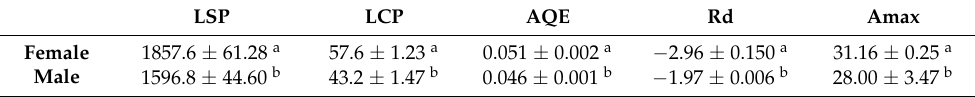
Table 3. Characteristic parameters of Pn-PAR in male and female H. tibetana